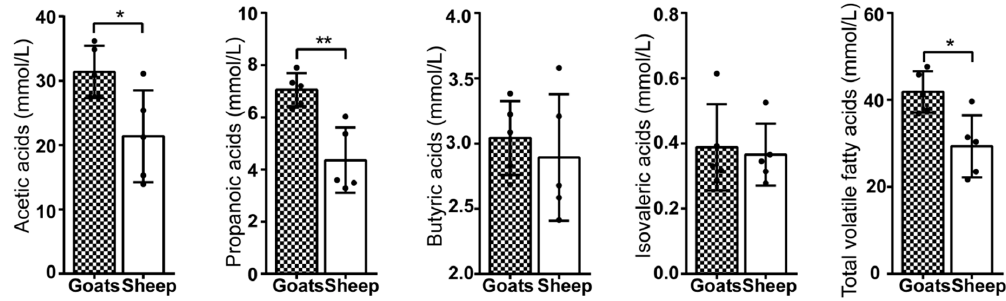
Figure 5. The concentrations of volatile fatty acids. The volatile fatty acids level in rumen and One- way ANOVA analysis between goats and sheep group are shown. * p < 0.05, ** p < 0.01, *** p < 0.001.